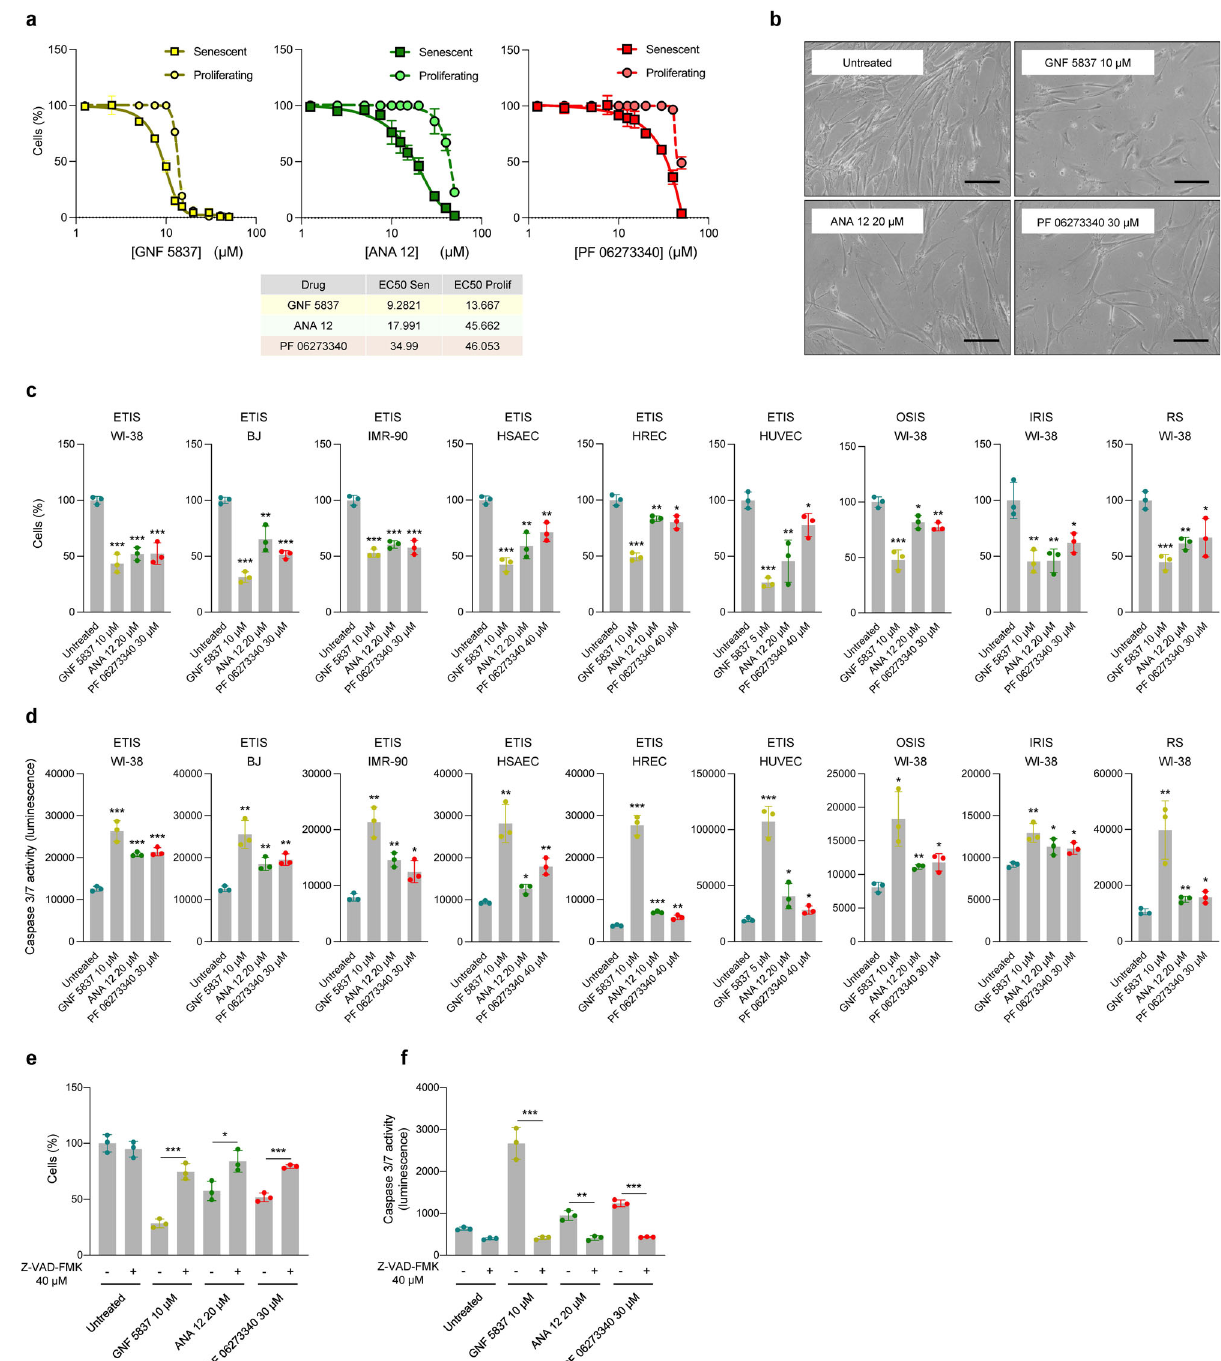
Fig.2 |PharmacologicalinhibitionofTrkBselectivelyinducesapoptoticdeath ofsenescentcells.a Viabilitycurvesobtainedaftertestingarangeofconcentrations of Trk inhibitor drugs (GNF 5837, ANA 12, PF 06273340) for 48h in WI-38 fi broblasts that were either proliferating or undergoing etoposide-induced senescence (ETIS). b Representativemicrographsofselectdosesforeachdrugtestedin( a );bar,100 µ m. Cell viability ( c ) and caspase 3/7 activity ( d ) were assessed 48h after the indicated treatments and doses in WI-38, BJ, IMR-90, HSAEC, HREC, and HUVEC cultures